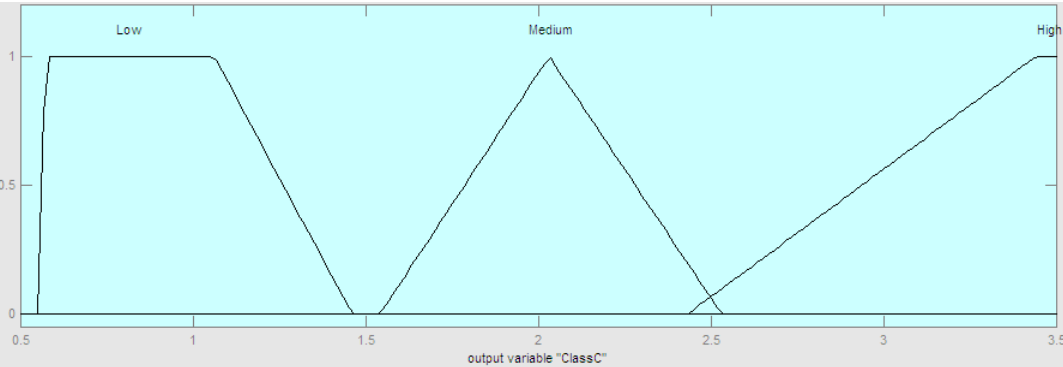
Figure 4. Fuzzy if-then rules expressing the classification knowledge in the fuzzy system.